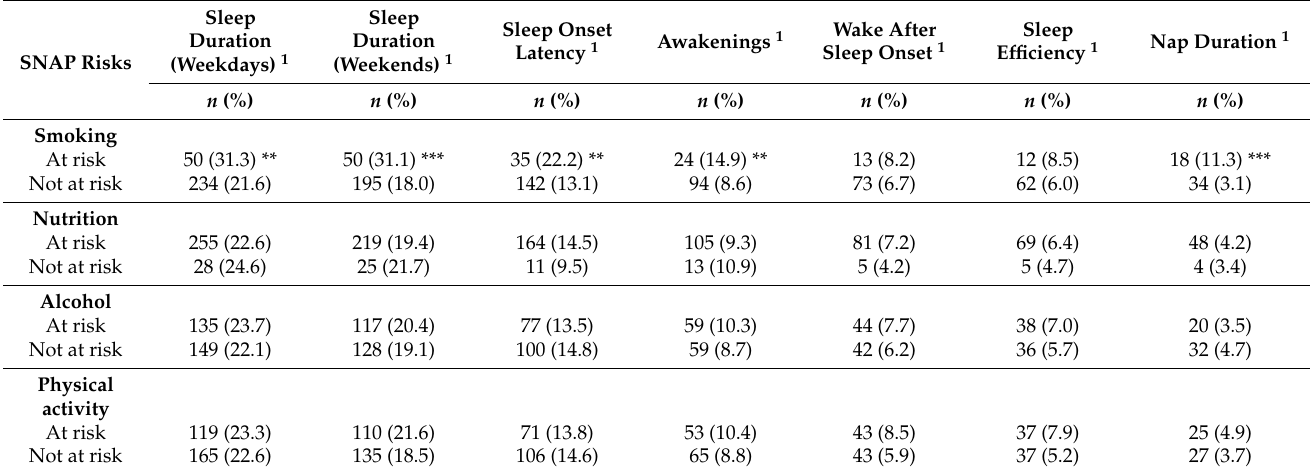
Table 4. Univariate Associations between SNAP risks and Suboptimal